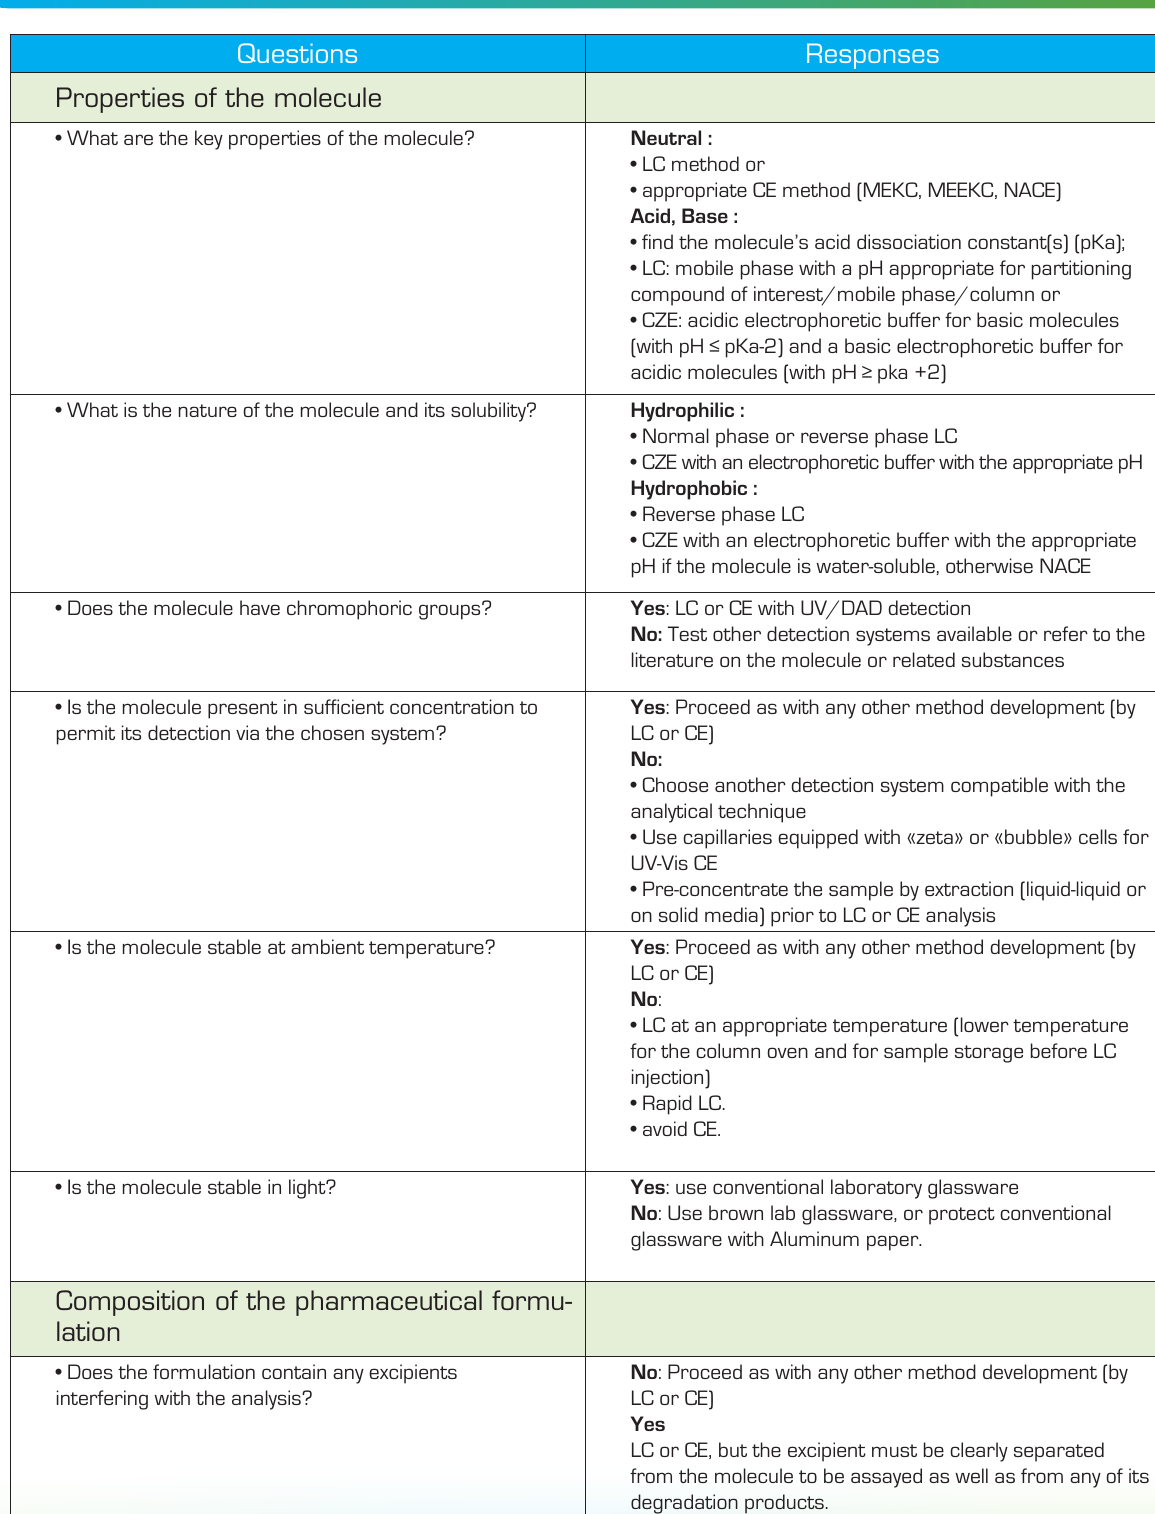
Table 4: Question-response pairs for the development of a stability indicating